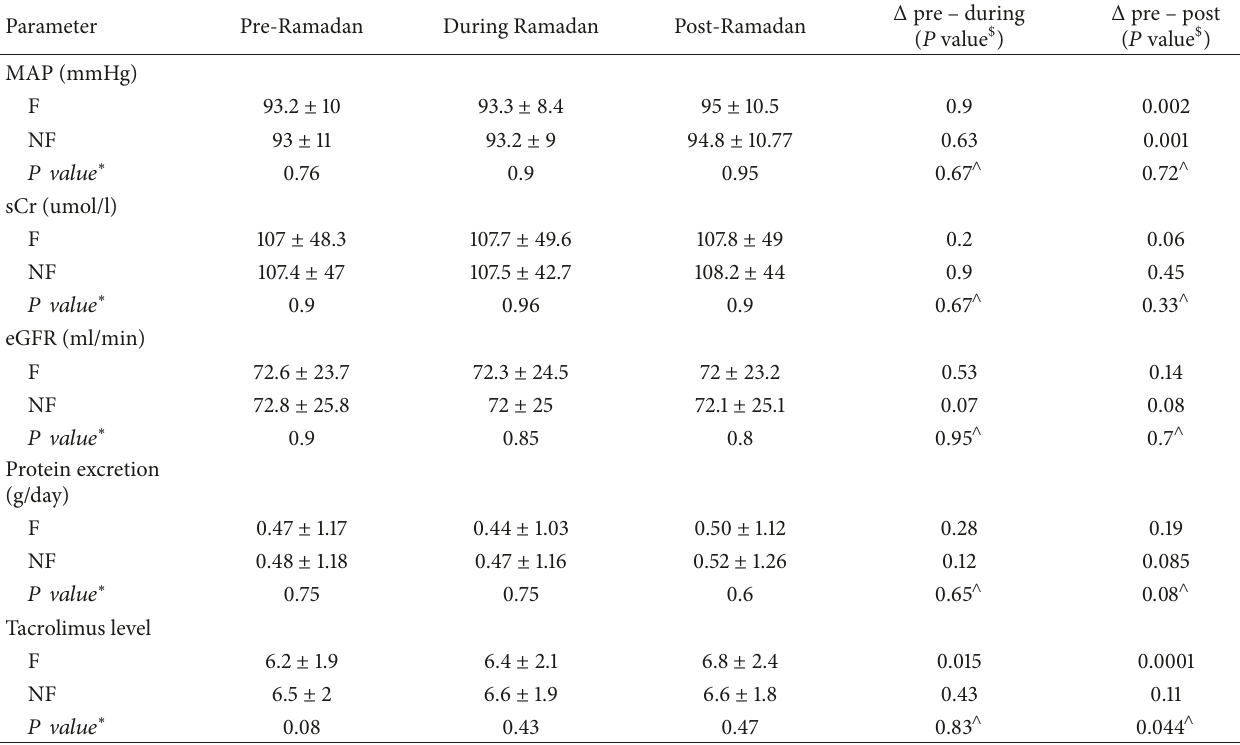
Table 2: Comparing changes in renal function and other parameters between baseline values and during and after Ramadan in fasting and non-fasting groups a , b .